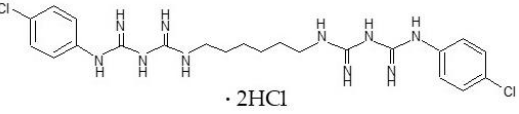
Figure 1. Chemical structure of CHX.